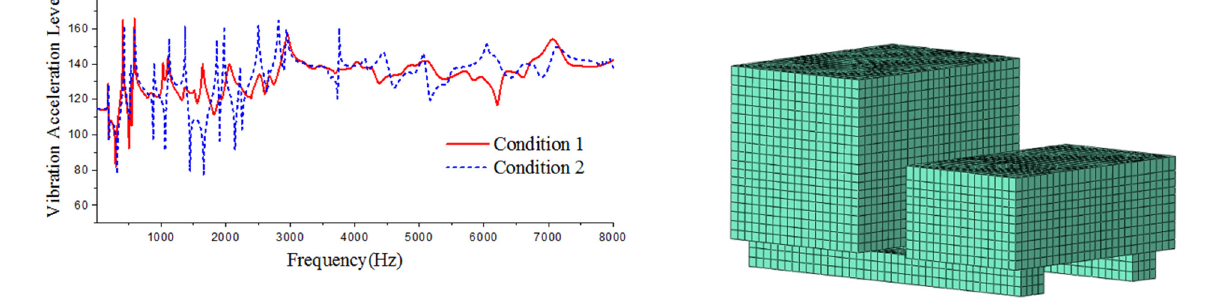
Figure 14: Vibration response of test points P 6 – P 8 for conditions 1 and 2.